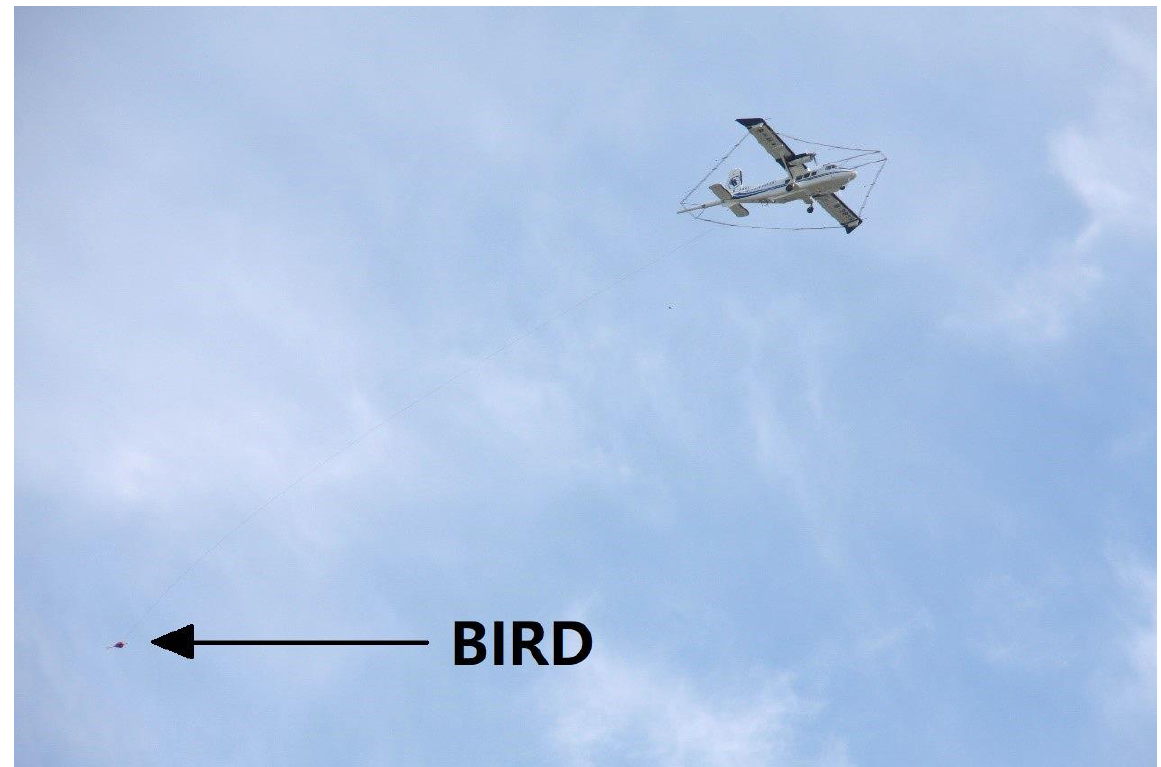
Figure 4. Overview of iFTEM- Ⅰ when it is flying.